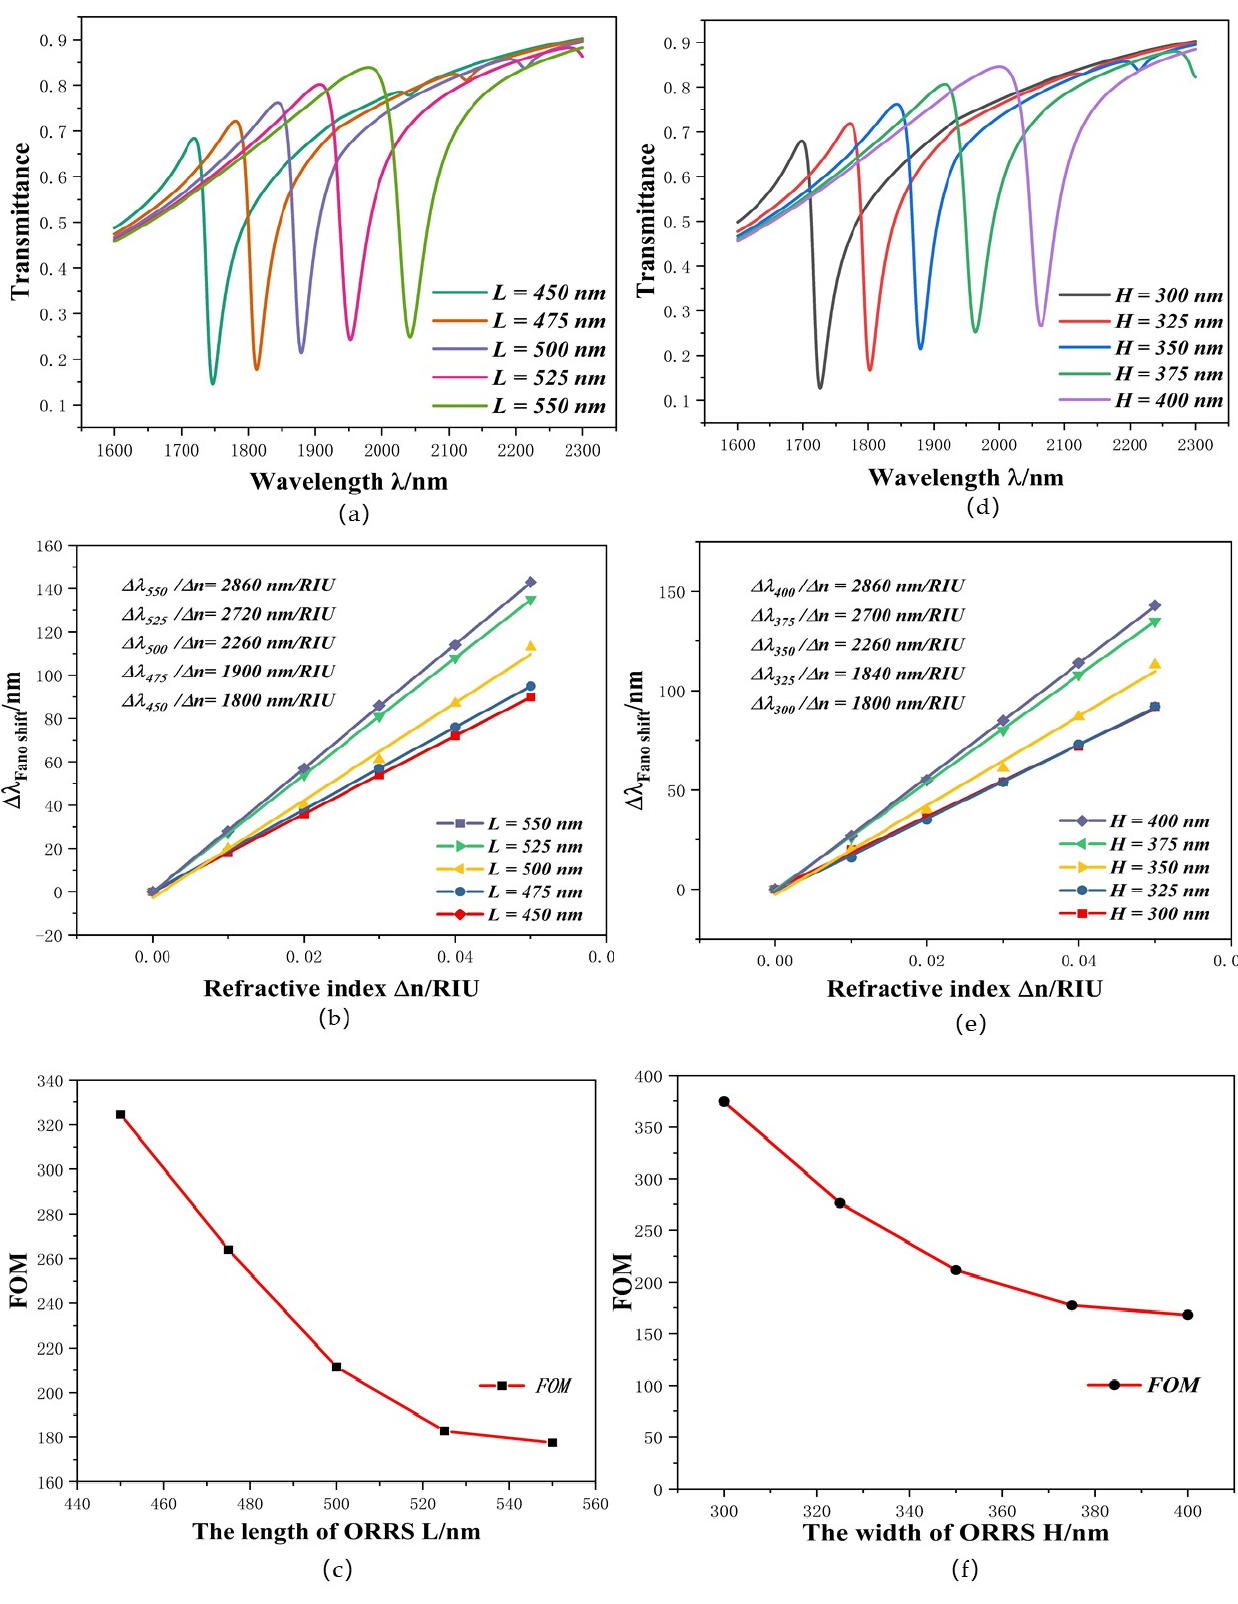
Figure 5. ( a ) ORRS transmission spectra under different L values; ( b ) S changes under different L values; ( c ) FOM changes under different L values; ( d ) SPPS transmission spectra under different H values; ( e ) S changes under different H values; ( f ) FOM changes under different H values.